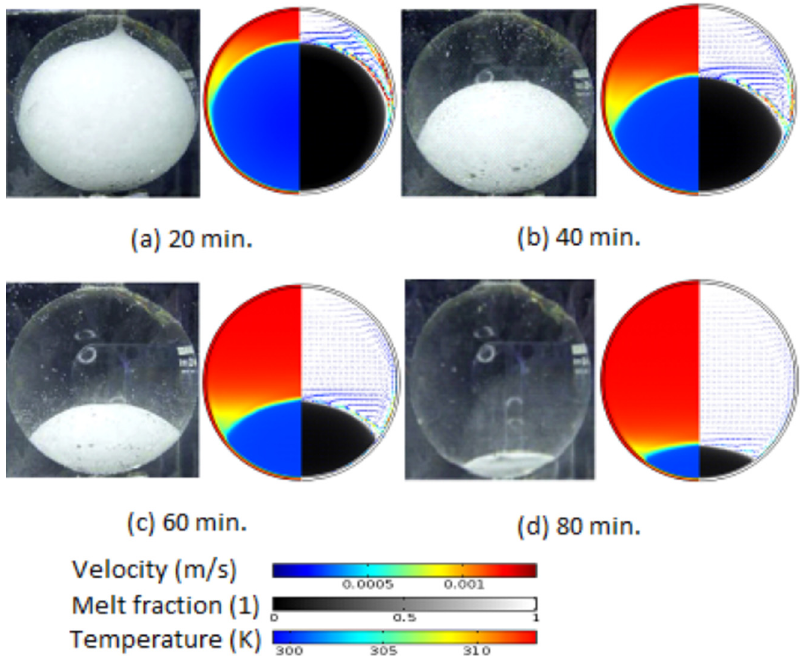
Fig. 2. Experimentally captured and numerically predicted melting front at various stages: (a) 20 min, (b) 40 min, (c) 60 min and (d) 80 min.